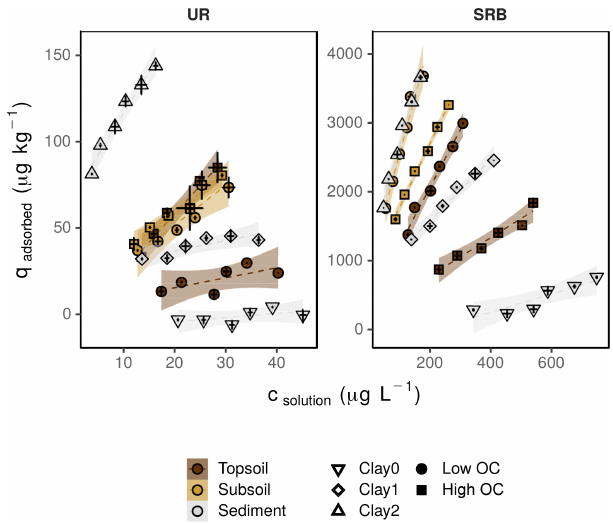
Figure 4. Sorption isotherms for UR and SRB in topsoil (brown), subsoil (yellow) and sediment (grey) under different OC (filled sym- bols) and clay (open symbols) conditions. The high OC treatments (square) represent the untreated samples, low OC (circle) the H 2 O 2 - treated samples. Clay0 (down-pointed triangle) represents the sed- iment without clay addition, and Clay1 (diamond) and Clay2 (up- pointed triangle) are sediment plus 1% and 2% clay addition. The error bars represent the standard deviation of the tracer concentra- tion measured in solution ( c solution ) and the calculated content of the adsorbed tracer ( q adsorbed ) ( n = 3). Note the different concen- tration ranges of UR and SRB. The transparent areas around the regression lines represent the 95%-confidence